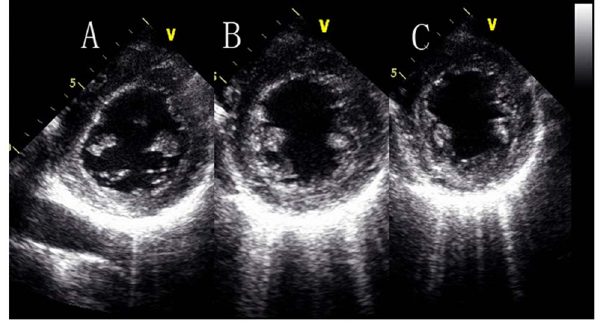
Figure 6. The papillary muscle short-axis levels at different locations. Figure 6A is a litter higher than the papillary muscle level but contain the papillary muscle, Figure 6B is in the middle of the papillary muscle level and Figure 6C is a litter lower than the papillary muscle level but contain the papillary muscle.